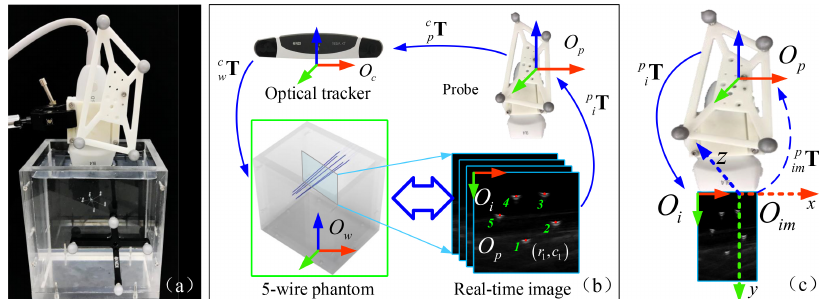
Figure 2. Schematic view of the US probe calibration based on a five-wire phantom; ( a ) experimental setup with a five-wire phantom; ( b ) spatial transformations involved in US probe calibration; ( c ) a schematic illustration on how to transform a pixel in the 2D US imaging space O i to the 3D-COS O p of the reference frame attached to the US